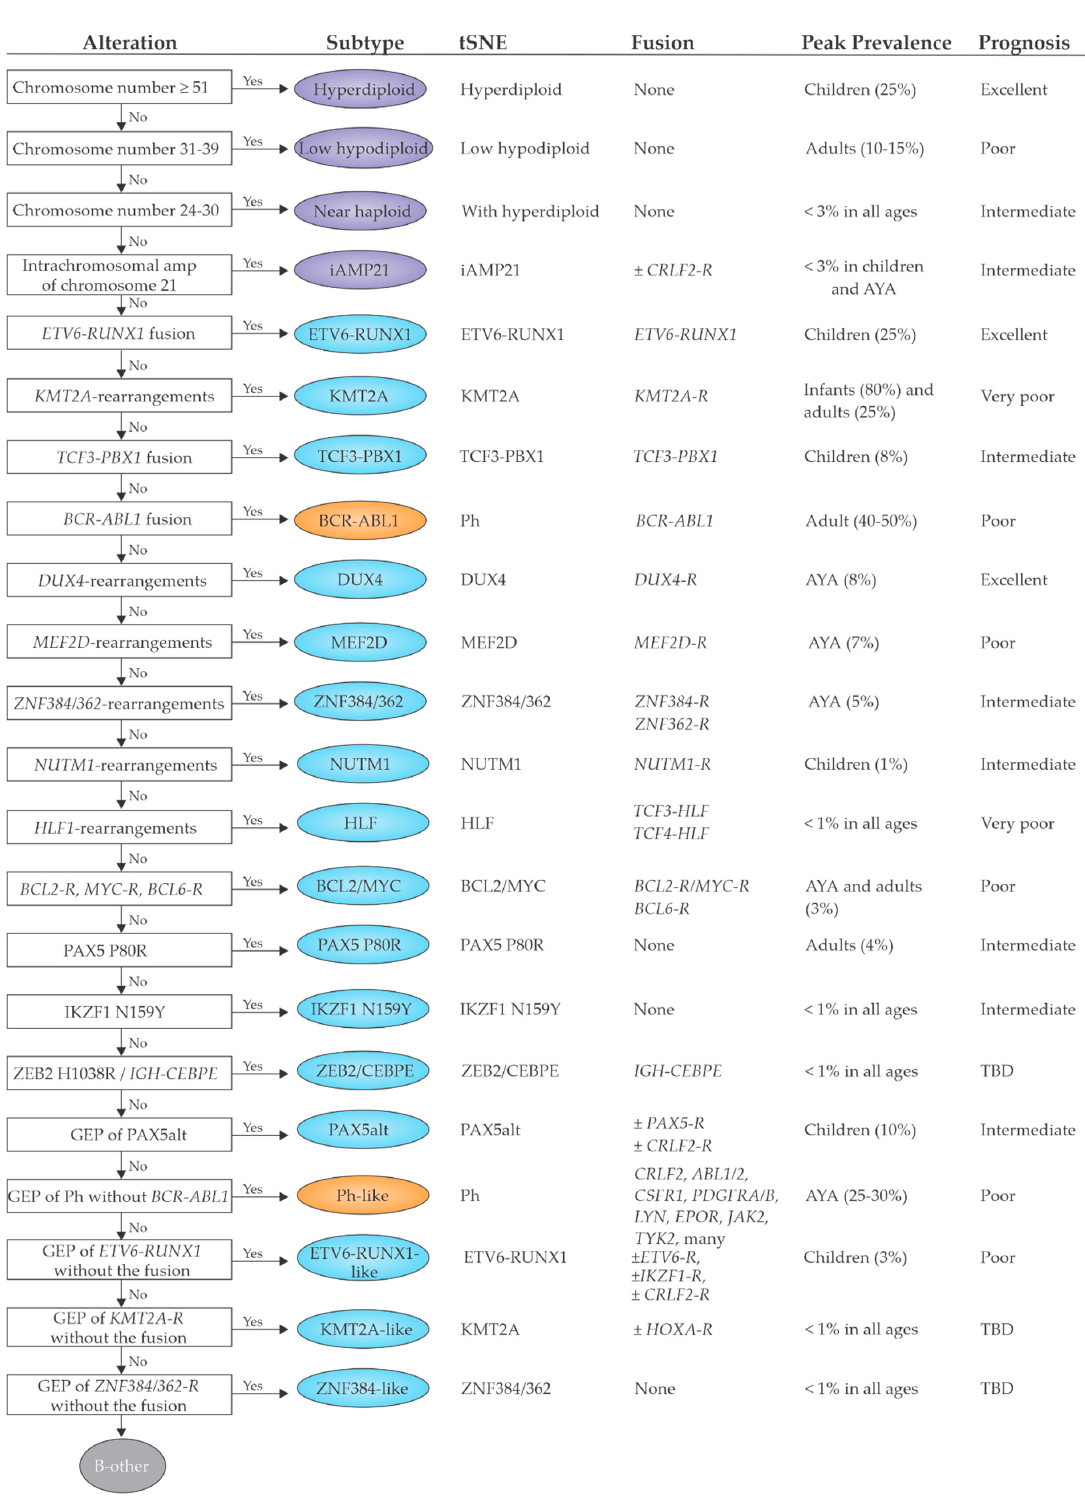
Figure 1. This schematic algorithm for B-ALL subtyping was modified from the figure originally published in Paietta E. et al. Molecular Classification Improves Risk Assessment in Adult BCR-ABL1-negative B-ALL. Blood Prepublished Apr 25 2021; doi:10.1182/blood.2020010144 [83]. This figure describes each B-ALL subtype according to the specific genetic alterations and gene expression profile. Moreover, for each subtype peak prevalence and prognosis are shown. Subtypes are colored according to defining genetic alteration: gross chromosomal abnormalities (purple), transcription factor rearrangements (blue), other transcription factor alterations (blue), and kinase alterations (orange). Abbreviations: AYA, adolescent and young adult; tSNE, t-distributed stochastic neighbor embedding; TBD: to be defined; -R: